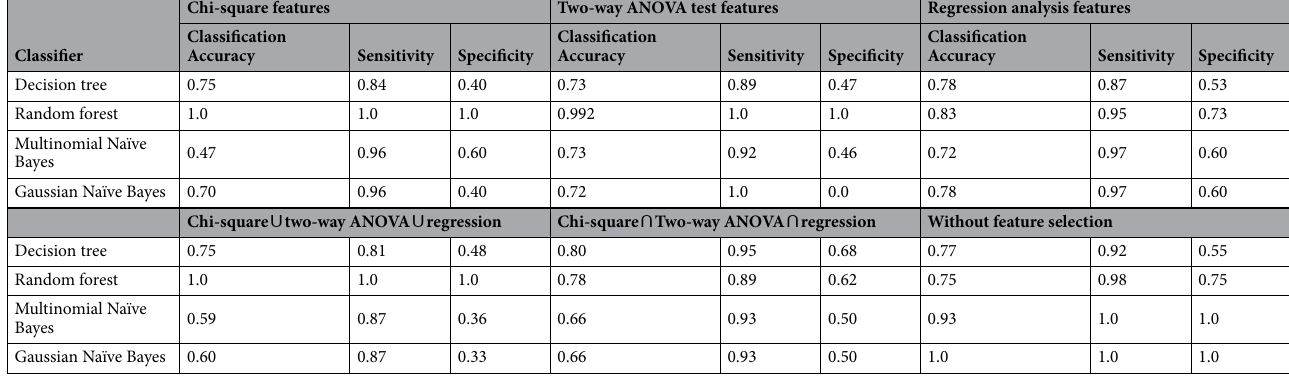
Table 3. Accuracy, Sensitivity, and Specificity of classifiers for several feature selection and non-feature selection